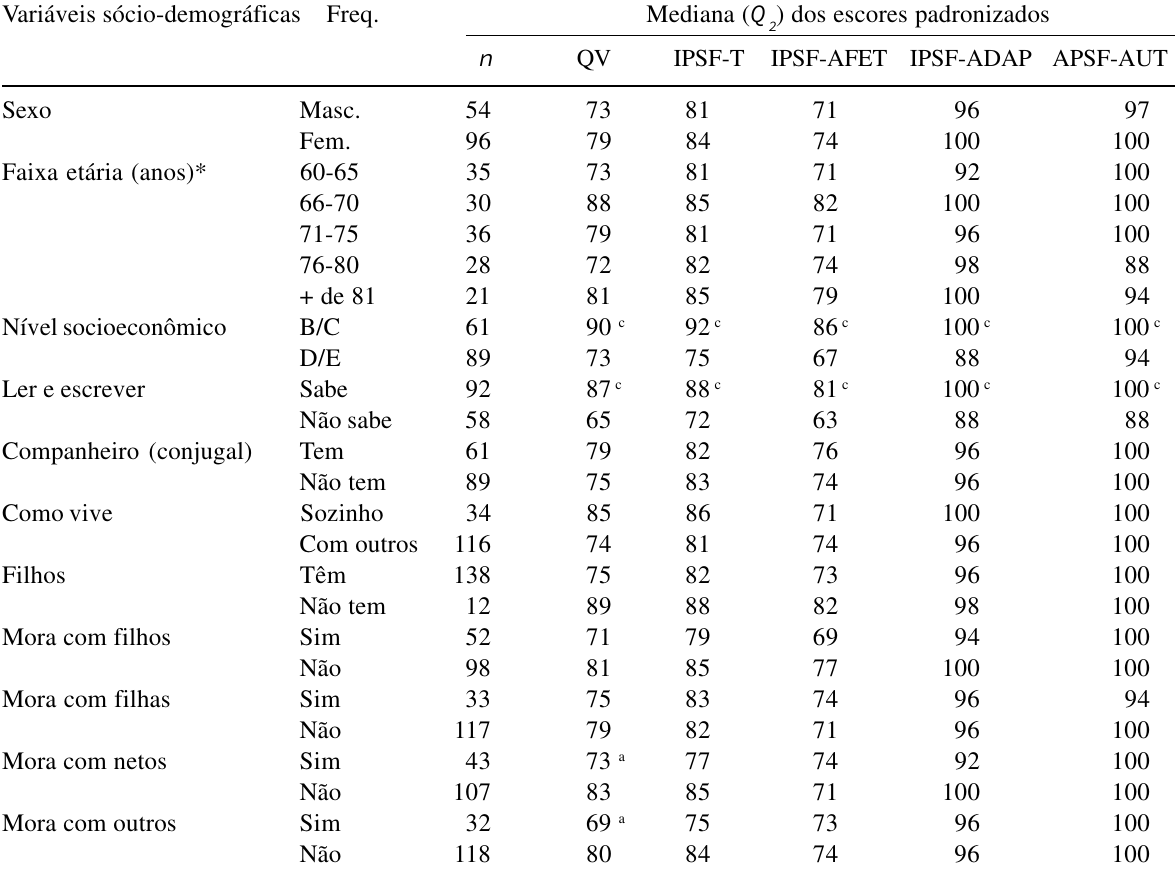
Valores Medianos (Q ) dos Escores Totais Padronizados de Qualidade de Vida (QV), Percepção de Suporte Familiar 2 Total (IPSF-T), Afetivo Consistente (IPSF-AFET), de Adaptação (IPSF-ADAP) e Autonomia (APSF-AUT) segundo as Variáveis Sócio-demográficas Categóricas Examinadas Junto aos Idosos